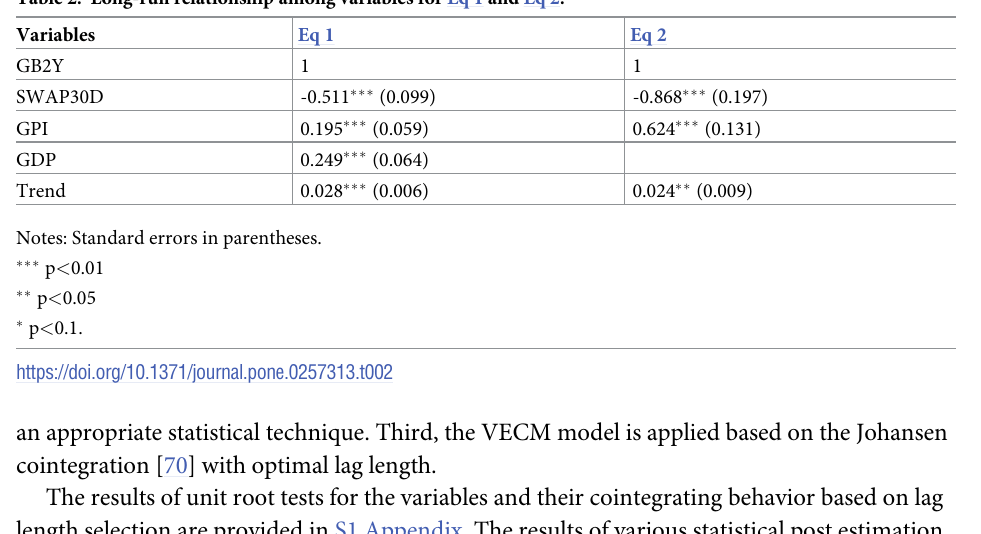
Table 2. Long-run relationship among variables for Eq 1 and Eq